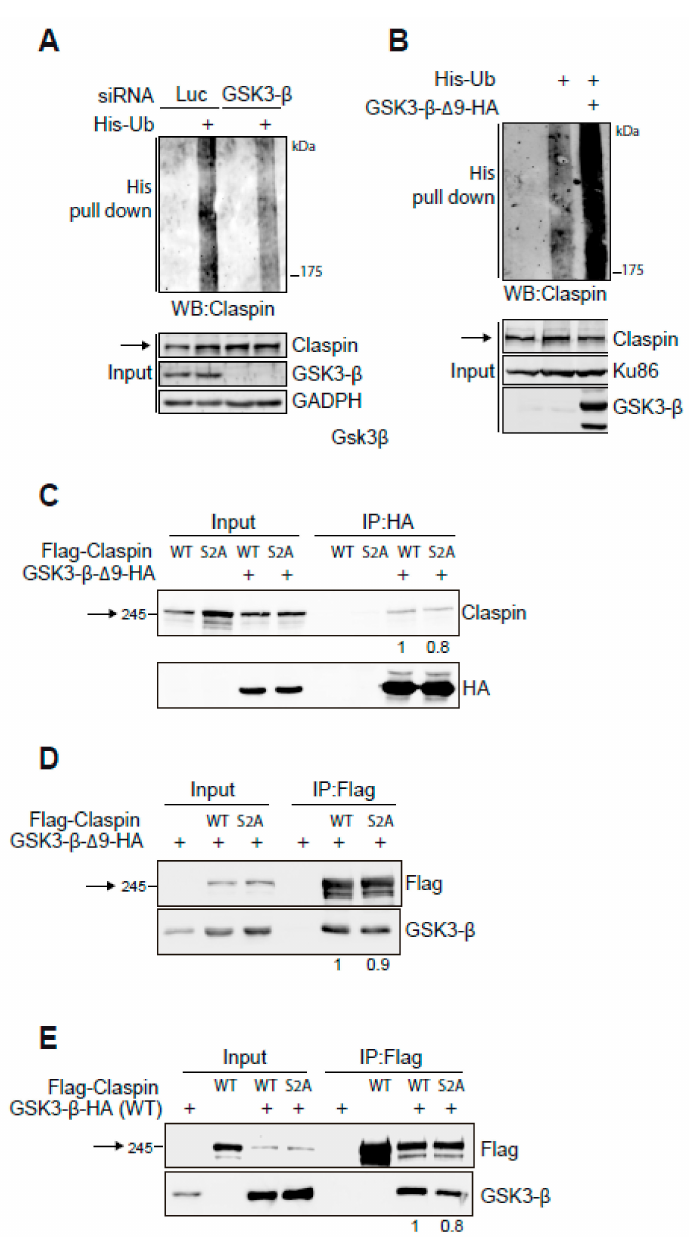
Figure 2. GSK3- β interacts with Claspin and promotes Claspin ubiquitination. ( A ) 293T, depleted for Luc or GSK3- β , were transfected with Flag-Claspin together with control or His-Ubiquitin plasmids. Cells were incubated with MG132 for 16 h before lysis under denaturing conditions. Western blot analysis of input and His-pulldowns were performed with the indicated antibodies. ( B ) Cells were transfected with Flag-Claspin, His-Ubiquitin and the GSK3- β - ∆ 9 mutant and incubated with MG132 for 16 h. Then cells were lysed and analysed as in ( A ). ( C , D ) 293T cells, transfected with GSK3- β - ∆ 9-HA and the indicated versions of Flag-Claspin (WT; wild type, S2A: Ser30A / Ser34A mutant), were treated with MG132 for 16 h prior to lysis. Extracts were immunoprecipitated with anti-HA ( C ) or anti-Flag ( D ) beads and input and immunoprecipitates were analysed by Western blot with the indicated antibodies. ( E ) As ( D ) but using wild type GSK3- β -HA. Arrows indicate Claspin. Quantifications of the co-immunoprecipitated protein are shown below each panel